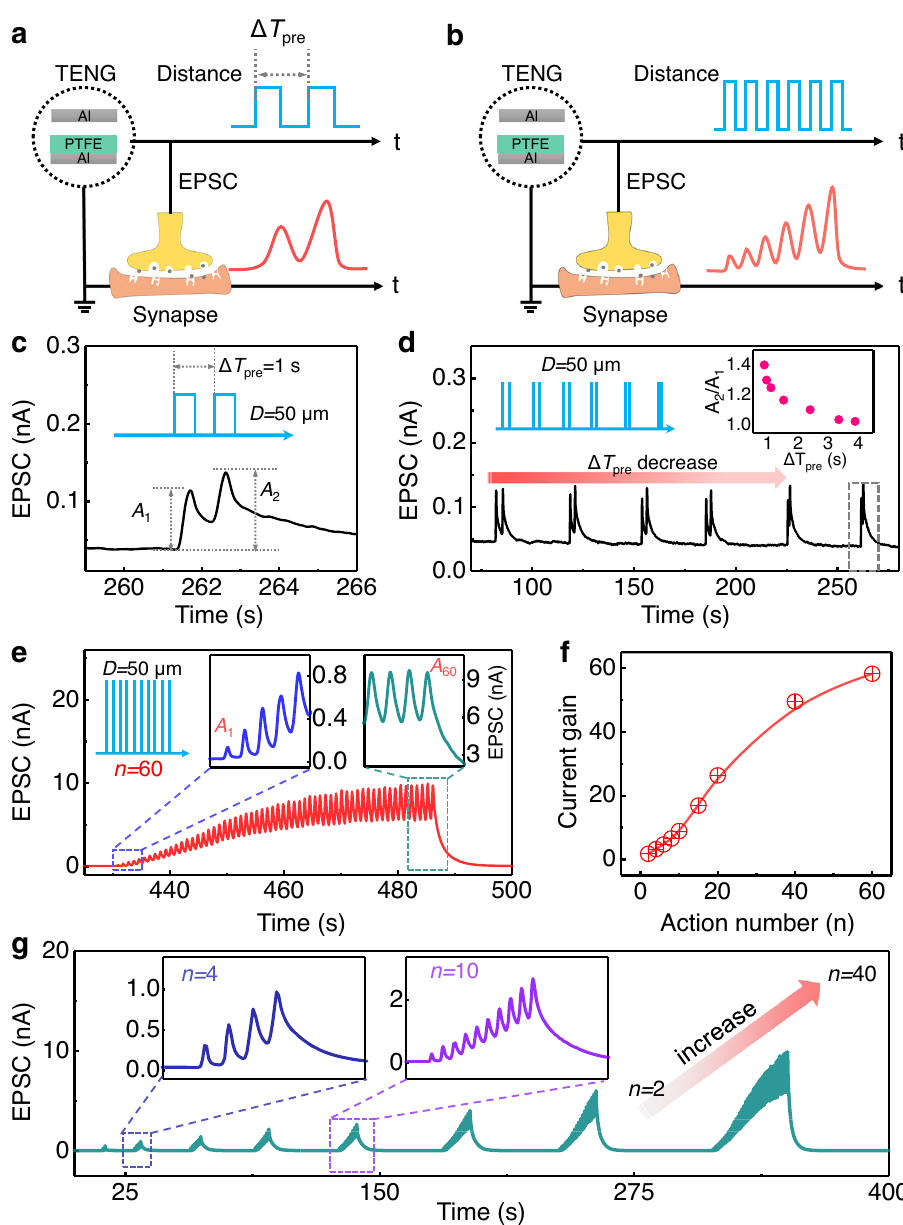
Fig. 3 The basic synaptic plasticity of CE-activated arti fi cial afferents. Schematic illustration of EPSCs activated by ( a ) paired CS actions and ( b ) multiple CS actions. c The typical EPSC responses under paired CS actions (interspike interval, △ T pre = 1 s). A 1 and A 2 represent the amplitudes of the fi rst and second EPSCs, respectively. d A series of EPSC responses activated by paired CS actions with different interspike intervals, with D = 50 μ m. The interspike interval decreases from 4 s to 1 s. Inset: the PPF index (de fi ned as the ratio of A 2 /A 1 ) vs. the interspike interval. e , The EPSC responses under 60 CS actions. Inset: an illustration of 60 CS actions (left) and the fi rst ( A 1 , middle) and last ( A 60 , right) current peak of the EPSCs. f The current gain (de fi ned as the ratio of A n /A 1 ) vs. action number. g Real-time EPSC responses to multiple CS actions; the number of actions ( n ) increases from 2 to 40. Inset: the EPSC responses under n = 4 (left) and n = 10